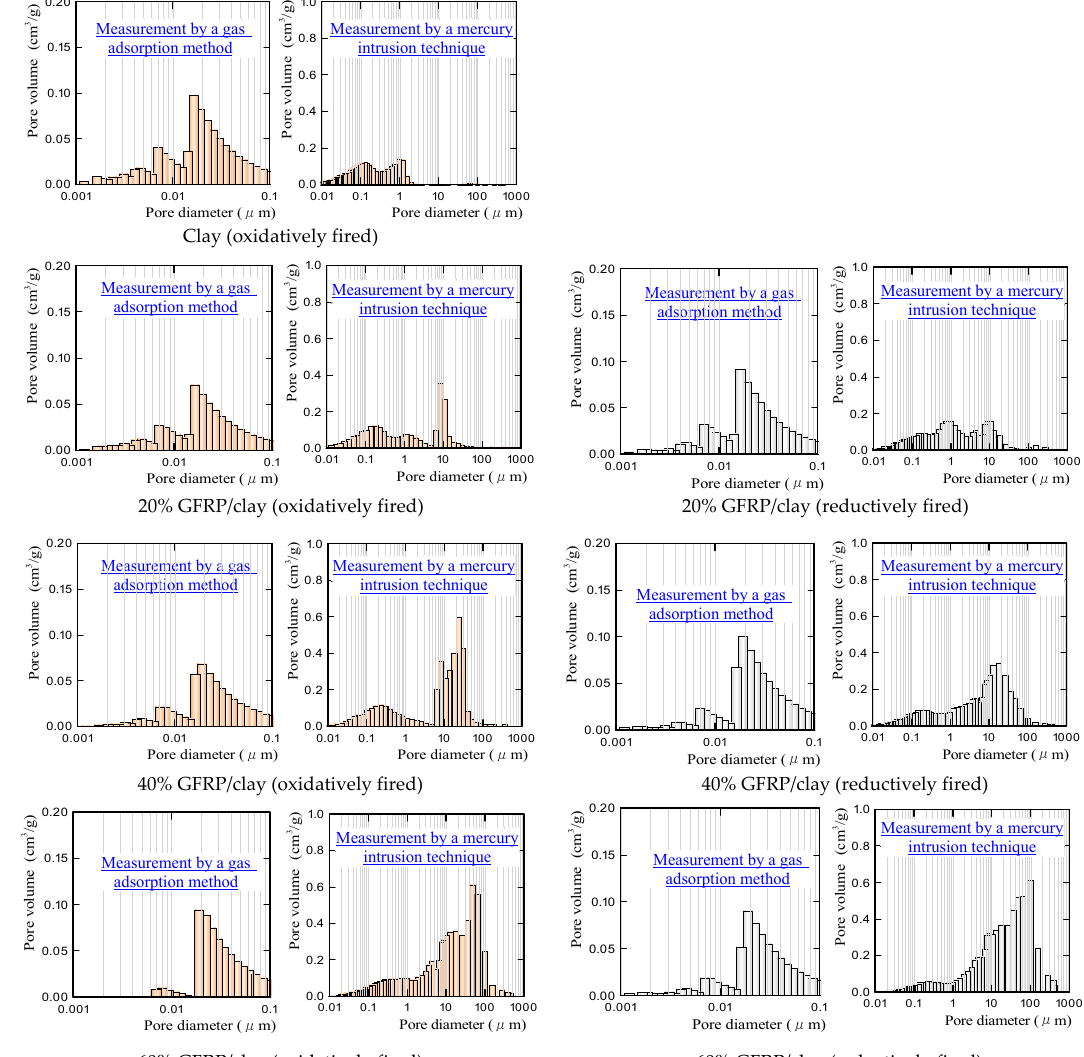
Figure 7. Ceramic pore-size distributions.